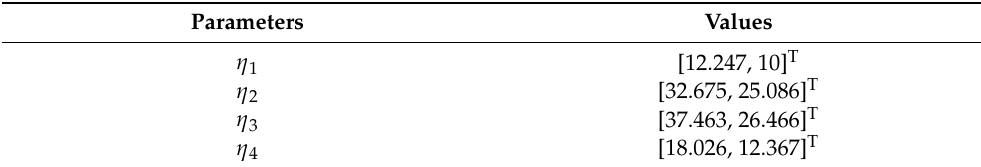
Table 3. Parameters of LQR controller.